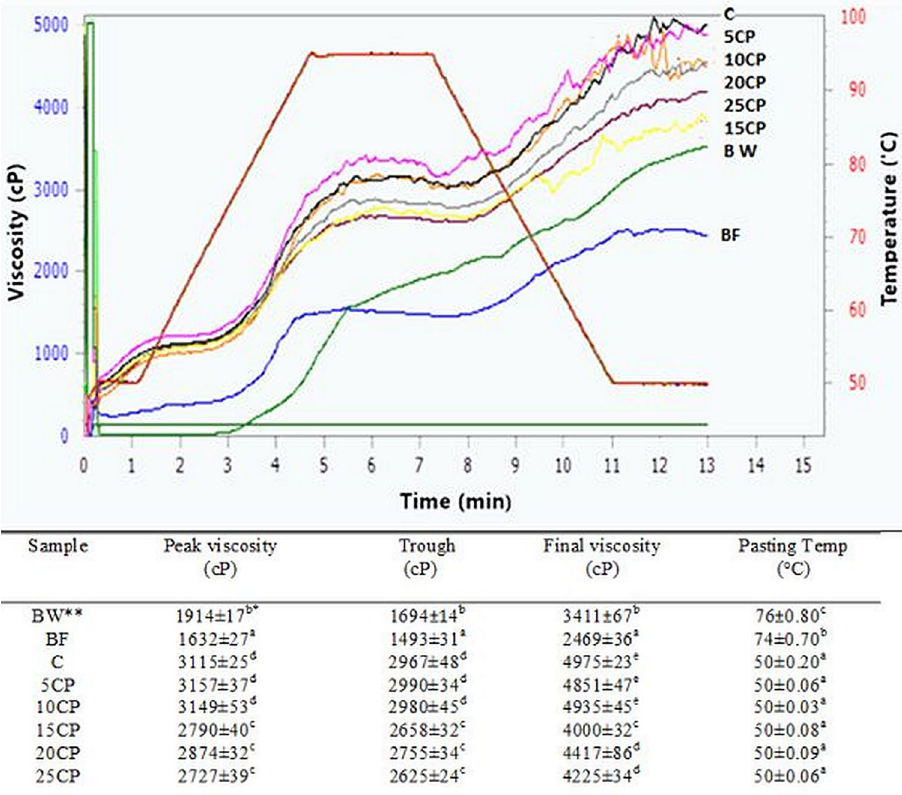
Figure 1. Pasting properties of studied flours, and blends with different concentration of pea protein powder: BW—buckwheat, BF—blend of buckwheat, and flaxseed flours; C—control sample, 5CP—blend of flours with 5% pea protein powder added, 10CP—blend of flours with 10% pea protein powder added, 15CP—blend of flours with 15% pea protein powder added, 20CP—blend of flours with 20% pea protein powder added, 25CP— blend of flours with 25% pea protein powder added . *Values in the same column marked with different letters are significantly (α = 0.05)